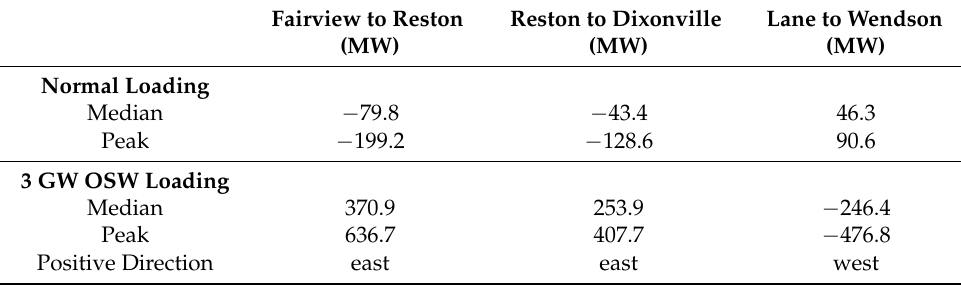
Table 4. Coastal transmission loading for Southern